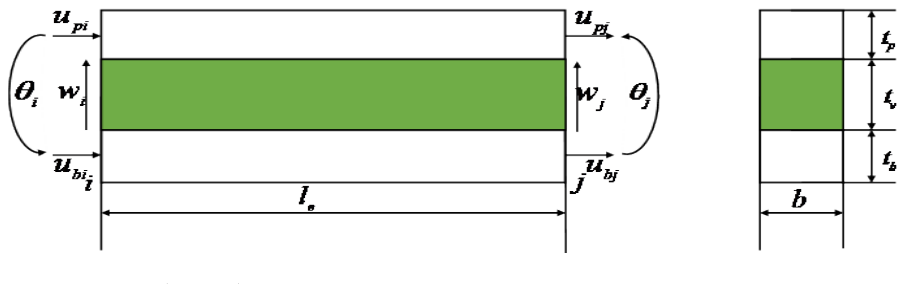
Figure 3. ACLD beam elements.